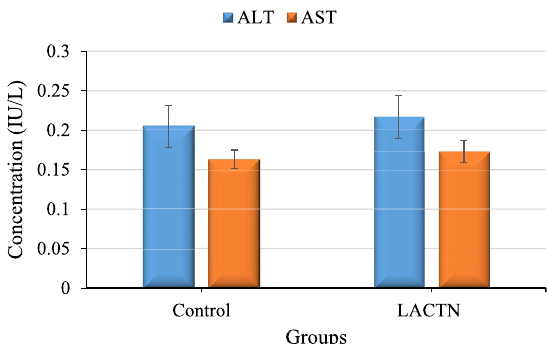
Fig. 2 Effect of LACTN on AST and ALT activities at an acute limit dose (5000 mg/kg b.wt).